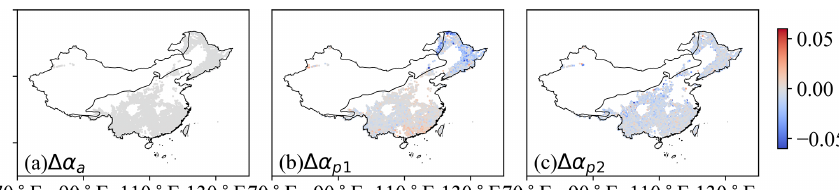
Figure A3. Spatial distribution of afforestation-induced changes in albedo ( α ) over China from three approaches: (a) actual albedo change following afforestation based on the space-and-time method ( (cid:49)α a ), (b) mixed potential albedo change using medium-resolution land-cover maps based on the space-for-time approach ( (cid:49)α p ), and (c) full potential effect ( (cid:49)α p ) based on the SVD approach. 1 2